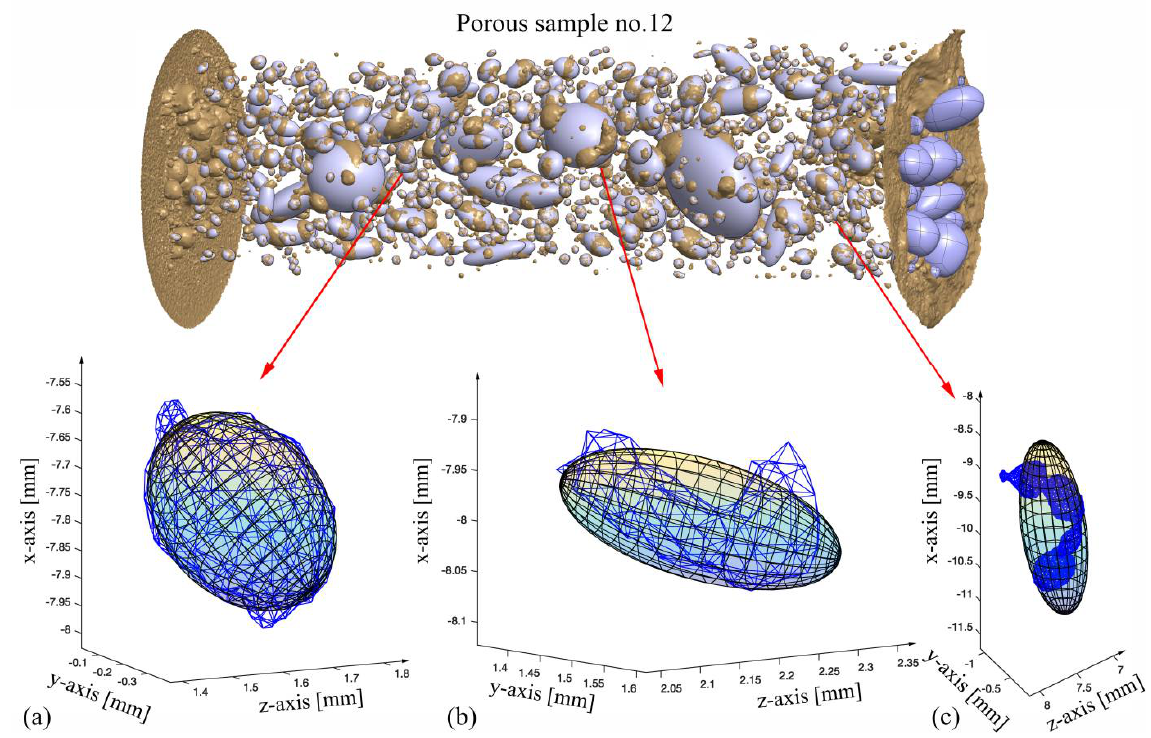
Figure 6. A comparison of the μ -CT scan and the extracted ellipsoids for the Specimen no. 12 (above); three examples of the fitted ellipsoids with different goodness-of-fit (below). ( a ) High fitting; ( b ) medium fitting; ( c ) low fitting.